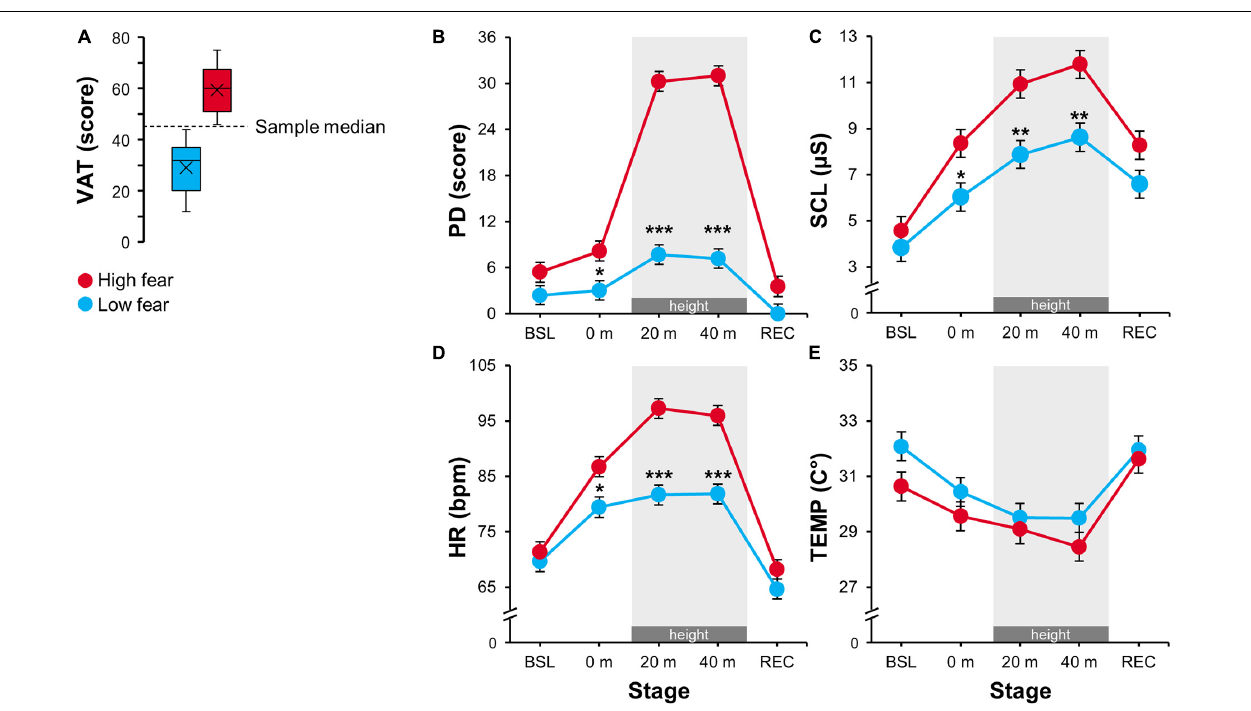
FIGURE 2 | (A) Visual acrophobia/anxiety test (VAT) score distribution for the low (VAT < 45) and the high (VAT > 45) fear group. (B–E) Estimated marginal means for the physiological and psychological parameters: PD, perceived distress; SCL, skin conductance level; HR, heart rate; TEMP, peripheral skin temperature in 0, 20, and 40 m virtual heights and also in baseline (BSL) and recovery (REC) stages. Error bars represent ± SEM. Grey areas highlight exposure to virtual height (20 and 40 m). Significant differences between the groups are marked as follows: * p < 0.05, ** p < 0.01, *** p <